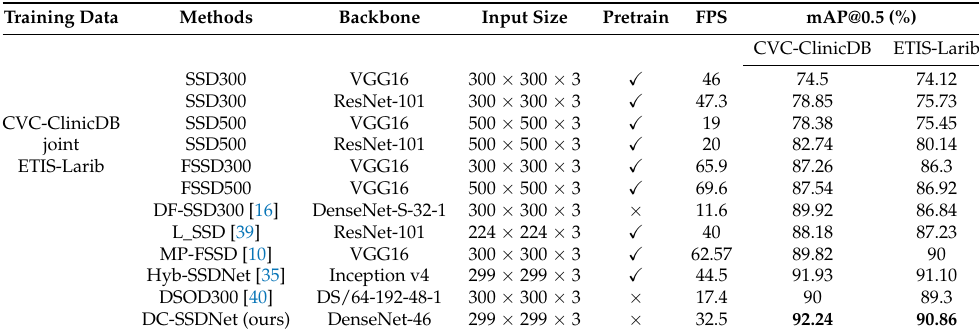
Table 5. SSD comparison with previously reported approaches based on CVC-ClinicDB and Etis-Larib test sets. Pretrain denotes a pretrained backbone to initialize the model, as opposed to starting from scratch. The Google Colab pro+ GPU was used to assess the speed (FPS) and performance (mAP). Training